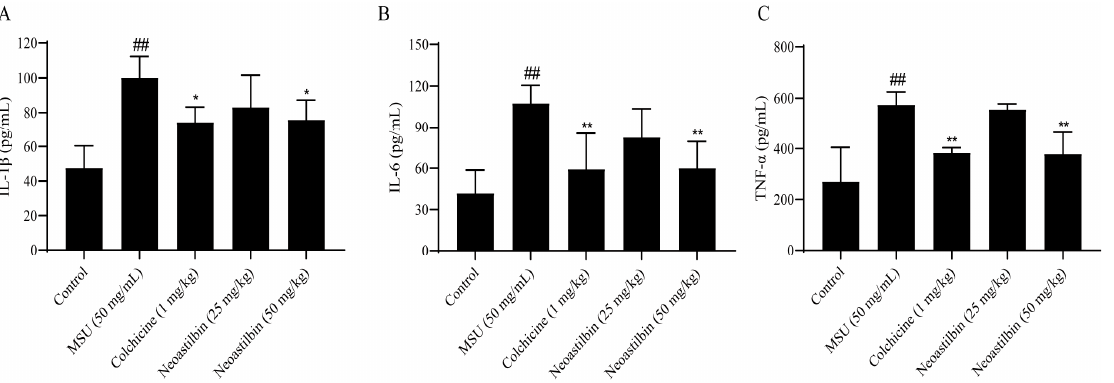
Figure 7. Effect of neoastilbin on the levels of inflammatory cytokines in GA mice. Mice were intragastrically administered neoastilbin (25 or 50 mg/kg) or colchicine (1 mg/kg) for 7 consecutive days. On the 6th day, MSU (50 mg/mL; 0.025 mL per mice) were injected into the ankle joints of the mice except the control group. After 24 h, ankle supernatants were analyzed by ELISA for IL-1 β ( A ), IL-6 ( B ) and TNF- α ( C ) levels. Data in the figures represent the means ± SD; significant differences among different groups are indicated as ## p < 0.01 vs. control group, * p < 0.05, ** p < 0.01 vs. MSU group ( n = 6).